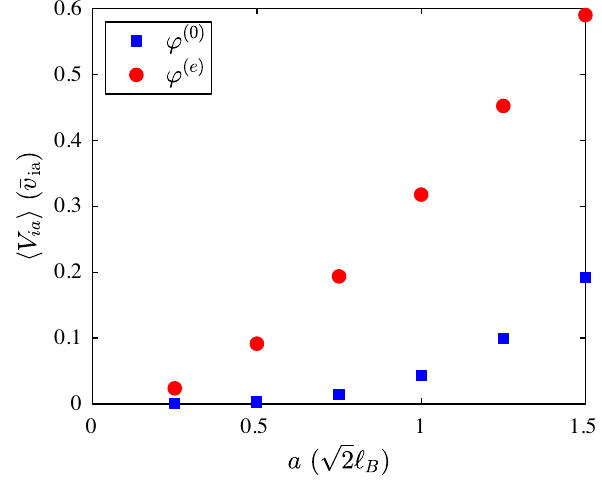
FIG. 9. Expectation value of the steplike interaction between impurities and atoms V in the ground state φ ð 0 Þ (blue squares) ia and in the lowest excited state φ ð e Þ (red circles) in units of ¯ v as a ia function of its step radius a (in units of l ). B